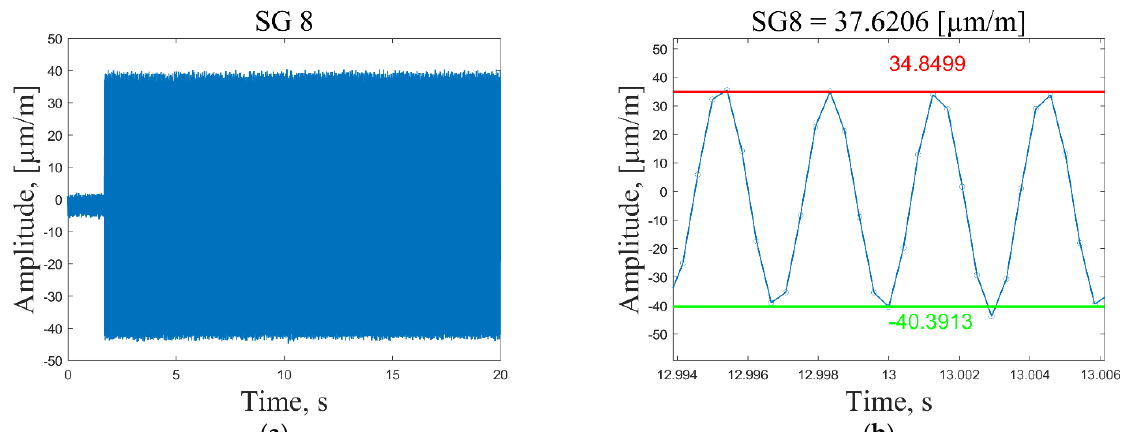
Figure 11. Recorded time series of strain response of the plate excited by a periodic sine wave signal corresponding to the first resonant frequency with a 3 V peak-to-peak vibration amplitude ( a ); cal- culated average peak-to-peak values for strain gauge 1 ( b ).